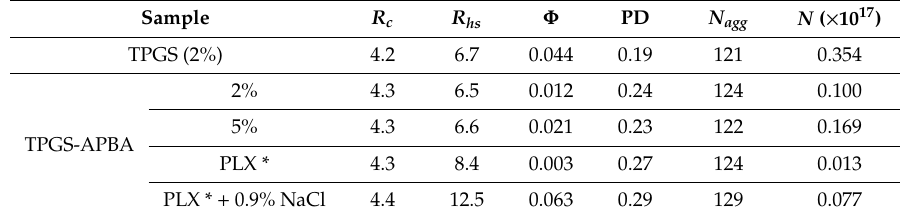
Table 1. Structural parameters of TPGS-APBA micelles obtained after fitting the data into spherical core-shell model.